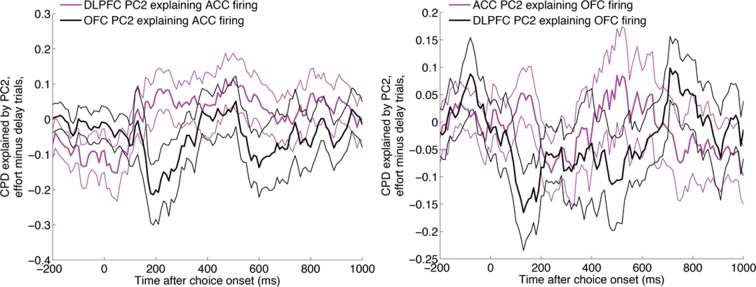
The same analysis as in main Figure 5, repeated with ACC firing being the dependent variable (left) and OFC firing being the dependent variable (right).